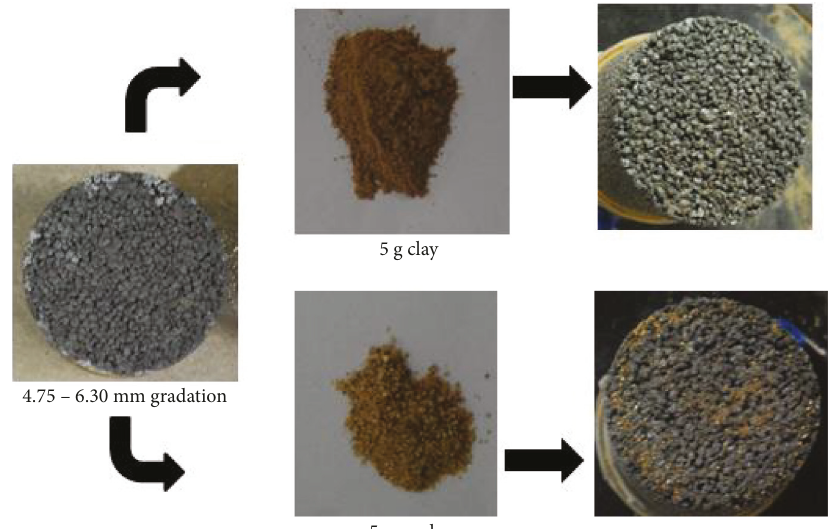
Figure 4: Clogging of clay and sand on the pervious concrete mix—4.75–6.30mm narrow